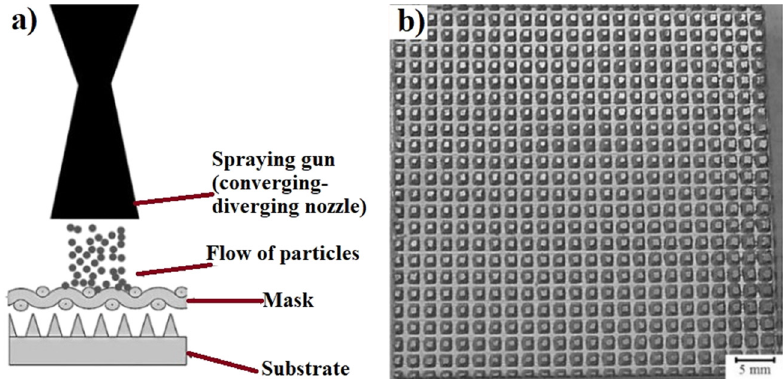
Figure 15: CSAM pyramidal fi n arrays heat sink: ( a ) schematic view of the manufacturing technique and ( b ) photograph of a CSAM fi n array heat sink [ 57 ]